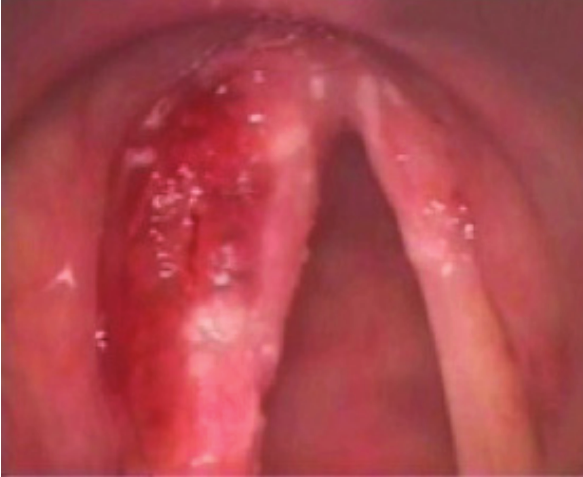
Figure 2: Microlaryngoscopic vision of the operative field after laser